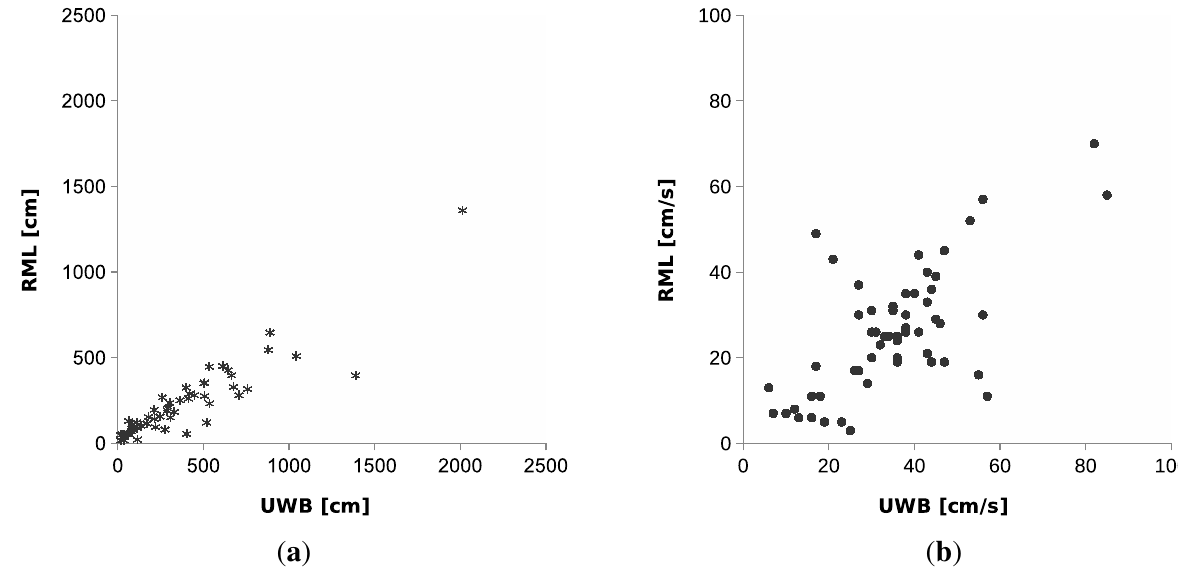
Scatter plot showing correlation between mobility statistics of each track computed from trajectories (both Sequence 1 and 2) of RML and UWB. ( a ) Total distance traveled per track; ( b ) Average speed per